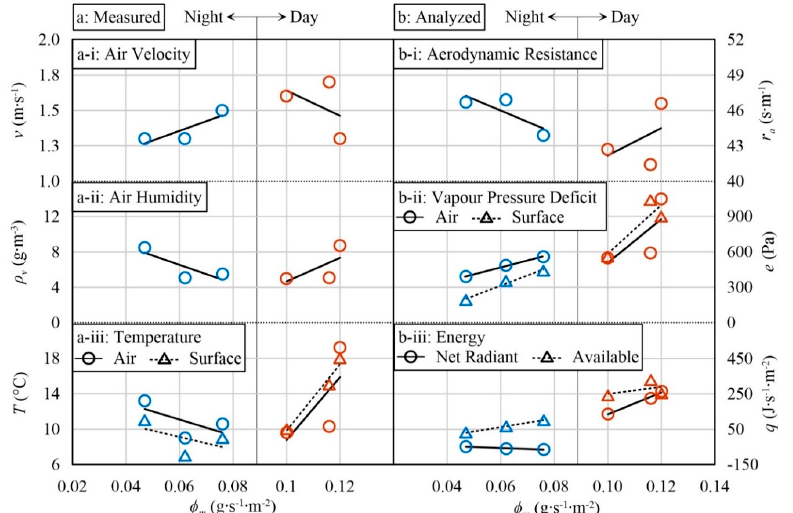
Figure 6. Effect of measured and analysed parameters on vapour flux ( φ m ): ( a-i ) air velocity, ( a-ii ) air humidity, ( a-iii ) air and surface temperatures, ( b-i ) aerodynamic resistance, ( b-ii ) air and surface vapour pressure deficits, and ( b-iii ) net radiant and available